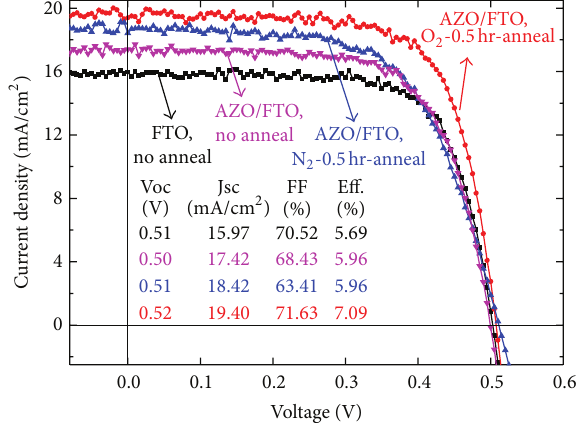
Figure 5: J-V characteristics of 1.2 𝜇 m-thick 𝜇 c-Si:H single-junction cells using the FTO or AZO/FTO with subsequent annealing in N 2 or O 2 environment as front